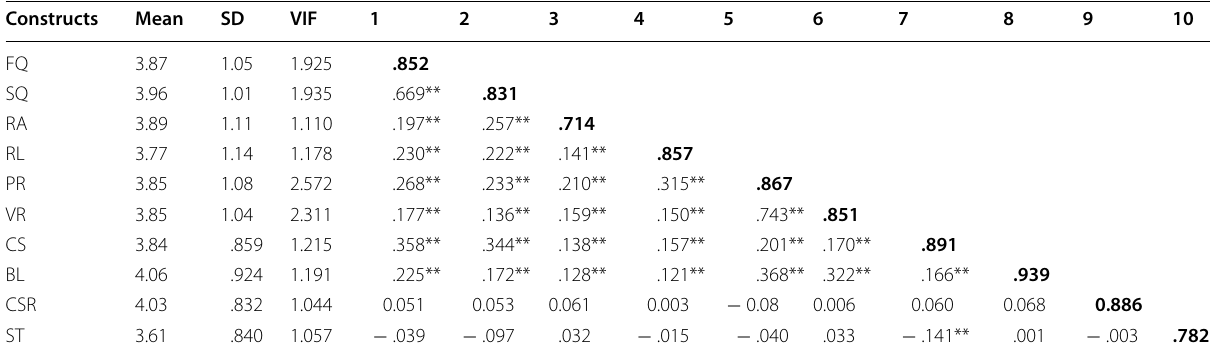
Table 3 Discriminant validity